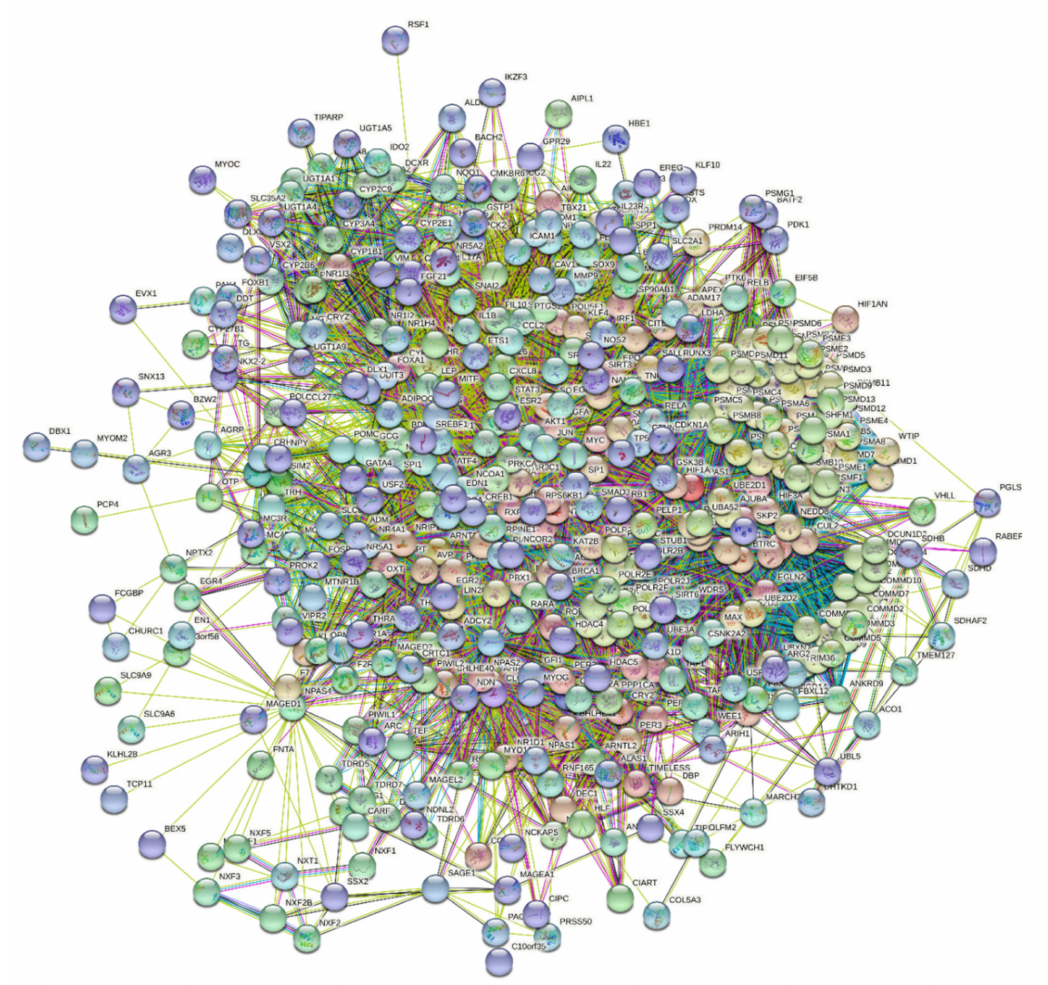
Figure 8. STRING-based external interactome of selected bHLH-PAS TFs with the “first shell” interactors. A confidence level of 0.5 was used in this